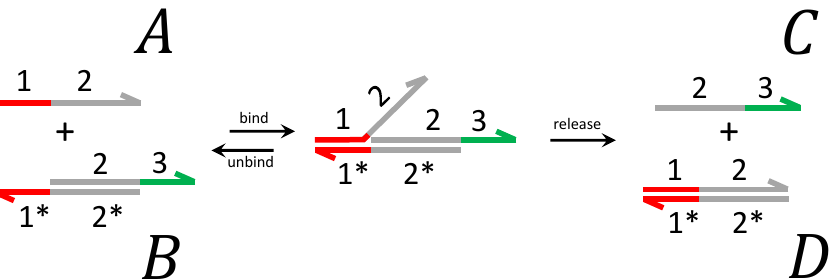
Figure 3. An illustration of a bimolecular DSD reaction of A + B → C + D that involves single- and double-strands. The hybridisation between overhanging complementary toeholds 1 and 1 ∗ initiates the displacement, resulting in competition for domain 2 ∗ between the incumbent strand and the incoming strand A . The hybridisation carries on till the incumbent is fully displaced, yielding new “species” C and D . There is an exposed toehold for the single-strand C , which can trigger other hybridisation reactions. In view of the absence of exposed toeholds, species D is deemed unreactive